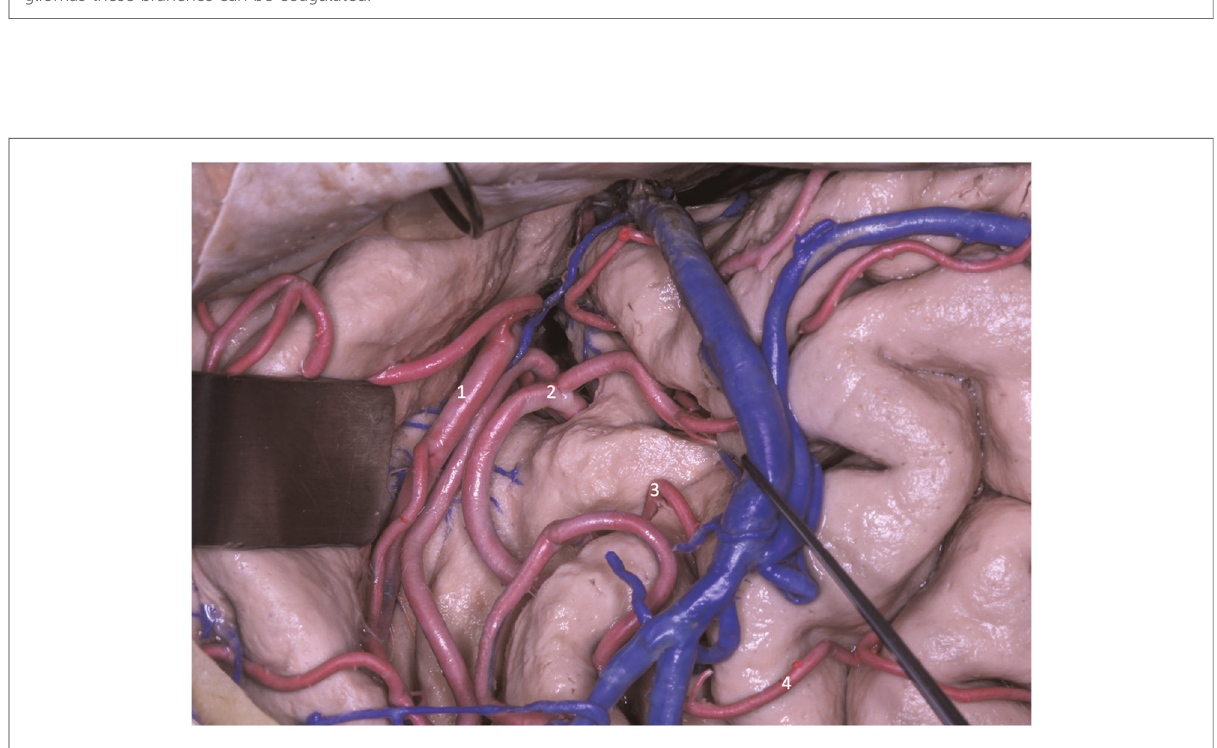
FIGURE 13 In the transsylvian approach, MCA segments M2 (1 and 2), M3 (3) and M4 (4) ACM are